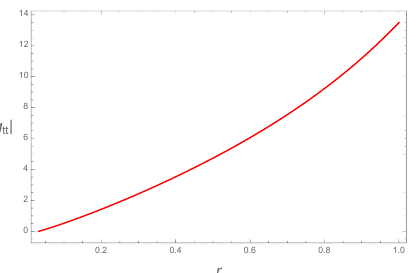
Figure 3 . The IR behaviour of j g j , as given by (4.8), for the supersymmetric (cid:13)ow once lifted (11) tt to eleven dimensions. That this component of the metric vanishes at the singularity is consistent with the singularity being \good" in the classi(cid:12)cation of [52]. Pictured is the (cid:16) = (cid:25)= 6